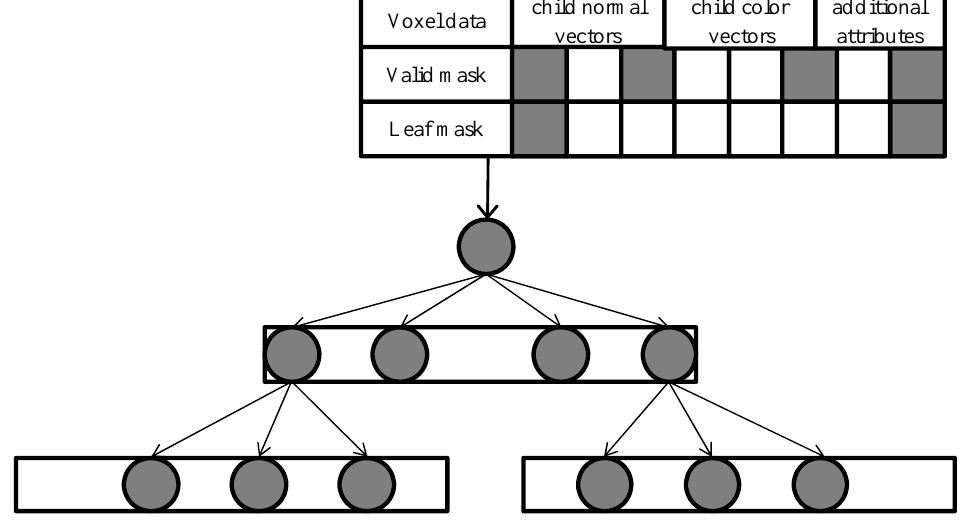
Figure 4. Illustration of the efficient sparse voxel octrees (ESVO) data structure (voxel data and topological descriptors).